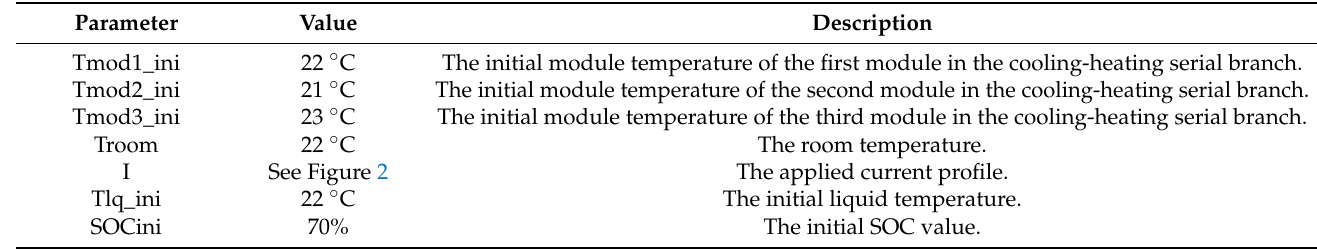
Table 4. Simulation operation conditions used to get the